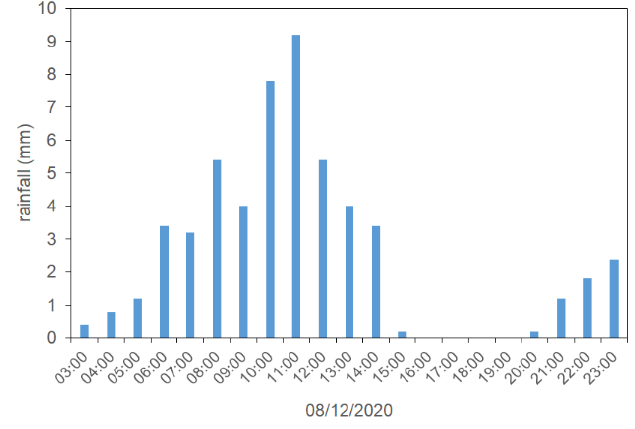
Figure 3. Bar chart showing the hourly rainfall measured by the rain gauge located in Collazzone on 8 December 2020. Data provided by the administration of the Umbria region.